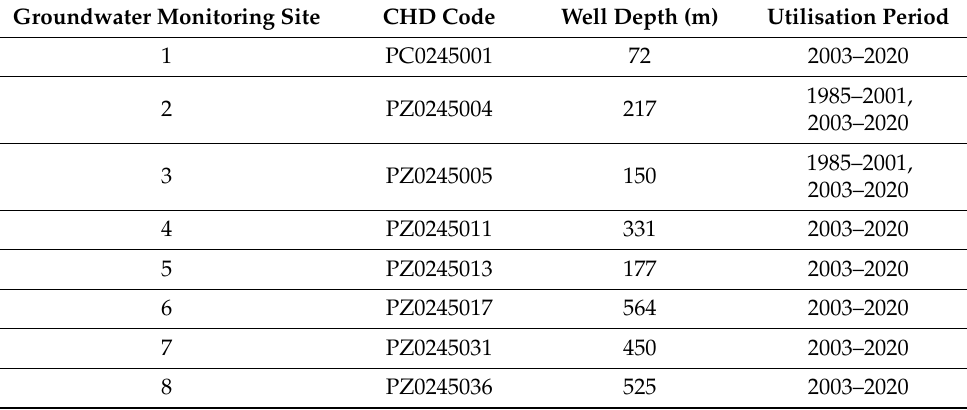
Table 1. Information from the groundwater monitoring sites where data were obtained to con- struct the annual average groundwater levels for the Los Arenales groundwater body (LAGB). The geographical location of these sites is shown in Figure 1 using the numbers in the first column (Groundwater Monitoring